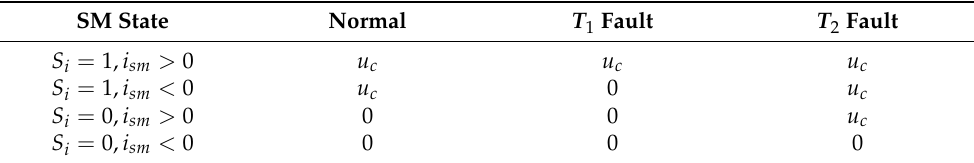
Table 1. Output voltages of SM in normal and fault cases.